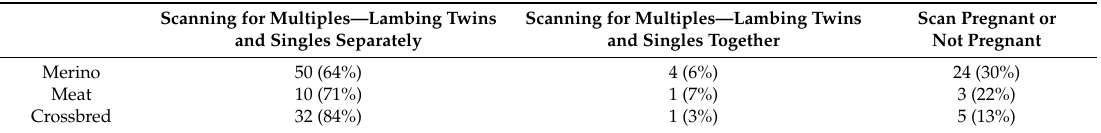
Table 2. Identification of scanning practice (either scanning for multiples or pregnant / not pregnant) and lambing groups (twins and singles, separate or together) for 104 NSW producers participating in a 2019 survey who identified to pregnancy scan ewes pre-lambing by Table 1. Sheep producers ( n = 145) participating in a NSW survey in 2019 identified lambing time of ewes by breed .